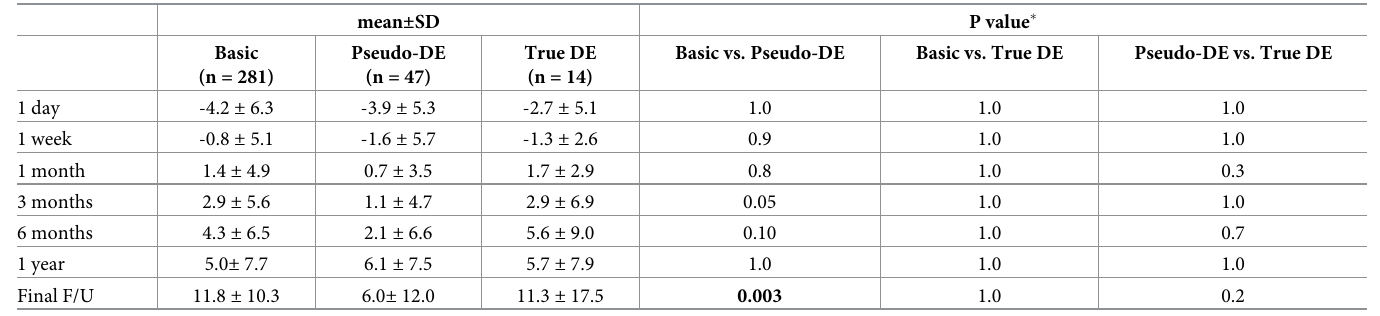
Table 3. Postoperative angles of deviation (PD) at distance.